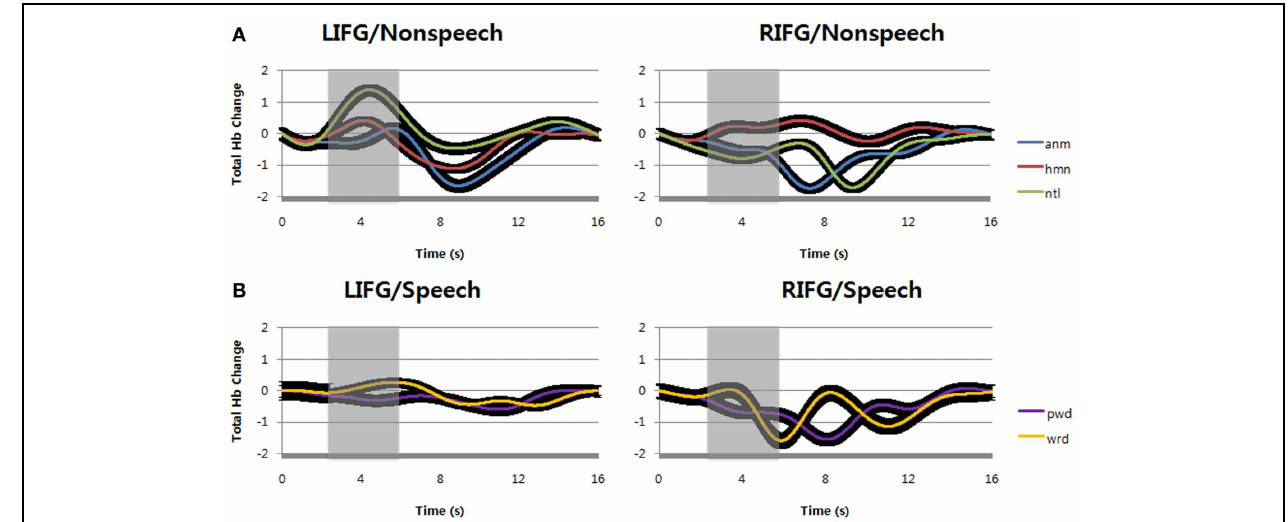
pseudowords (normalized). The black regions surrounding the signals show standard deviation. LIFG, left inferior frontal gyrus; RIFG, right inferior frontal gyrus; anm, animal vocalizations; hmn, human non-speech sounds; ntl, natural sounds; wrd, words; pwd,